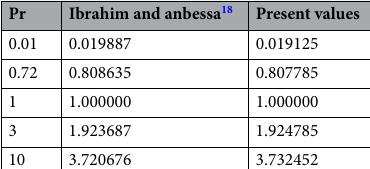
Table 2. Comparison of − θ ′ (0) for various values of Pr when Nb = 0.3, Nt = 0.7, P r = 0.71, Le = 0.6, M =